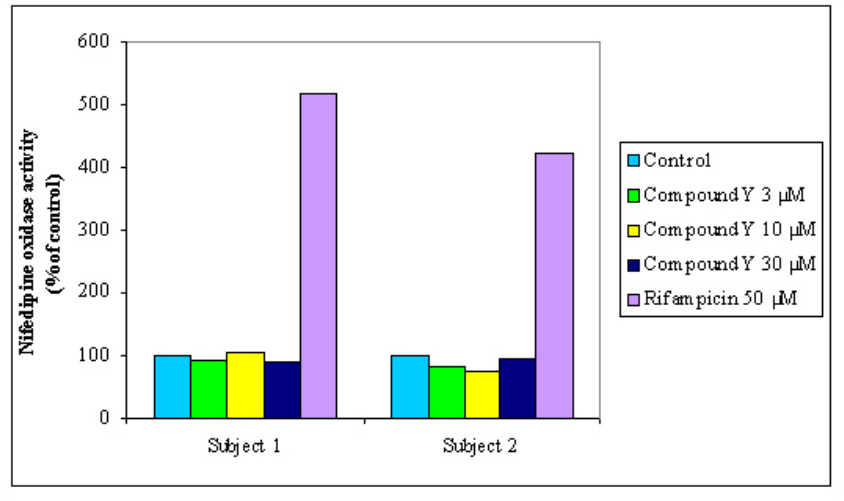
FIGURE 1. Induction of CYP3A4 in cultured human hepatocytes by rifampicin, a reference inducer and by a new NCE, called Y, at different concentrations. Figure and data kindly provided by Claire Guyomard, from BIOPREDIC, Rennes